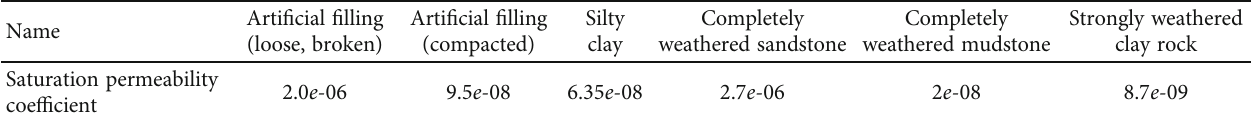
Table 3: Test results of saturated permeability coe ffi cient of landslide rock